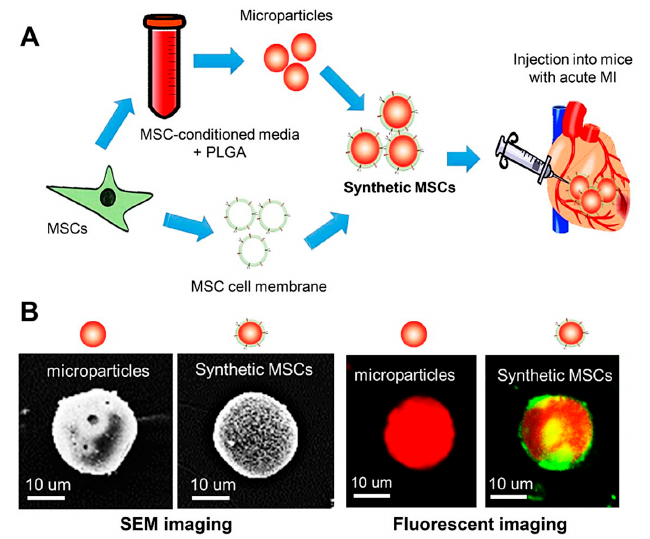
Figure 1. Fabrication and characterization of synthetic mesenchymal stem cell (synMSC). ( A ) Schematic illustration of the fabrication process of synMSC . Microparticles (MP) were fabricated by treating mesenchymal stem cells conditioned media with poly(lactic-co-glycolic acid) (PLGA). Synthetic mesenchymal stem cells (synMSC) were formed by coating the MP with MSC membranes. After that, we tested the therapeutic effects of synMSC injection in mice with acute myocardial infarction; ( B ) Scanning electron microscopy images (left) and fluorescent images (right) of the structure of MP and synMSC. MP were labeled with Texas Red succinimidyl ester (red) and synMSC, as cell membranes were labeled with green fluorescent DiO (red particle with green coat). Reproduced with permission [147].